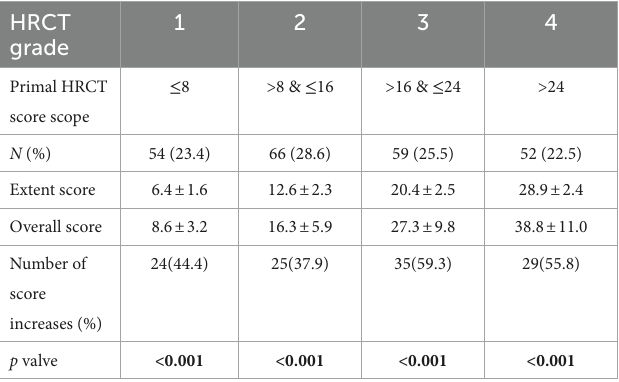
TABLE 1 Different HRCT score of patients with autoimmune APAP.